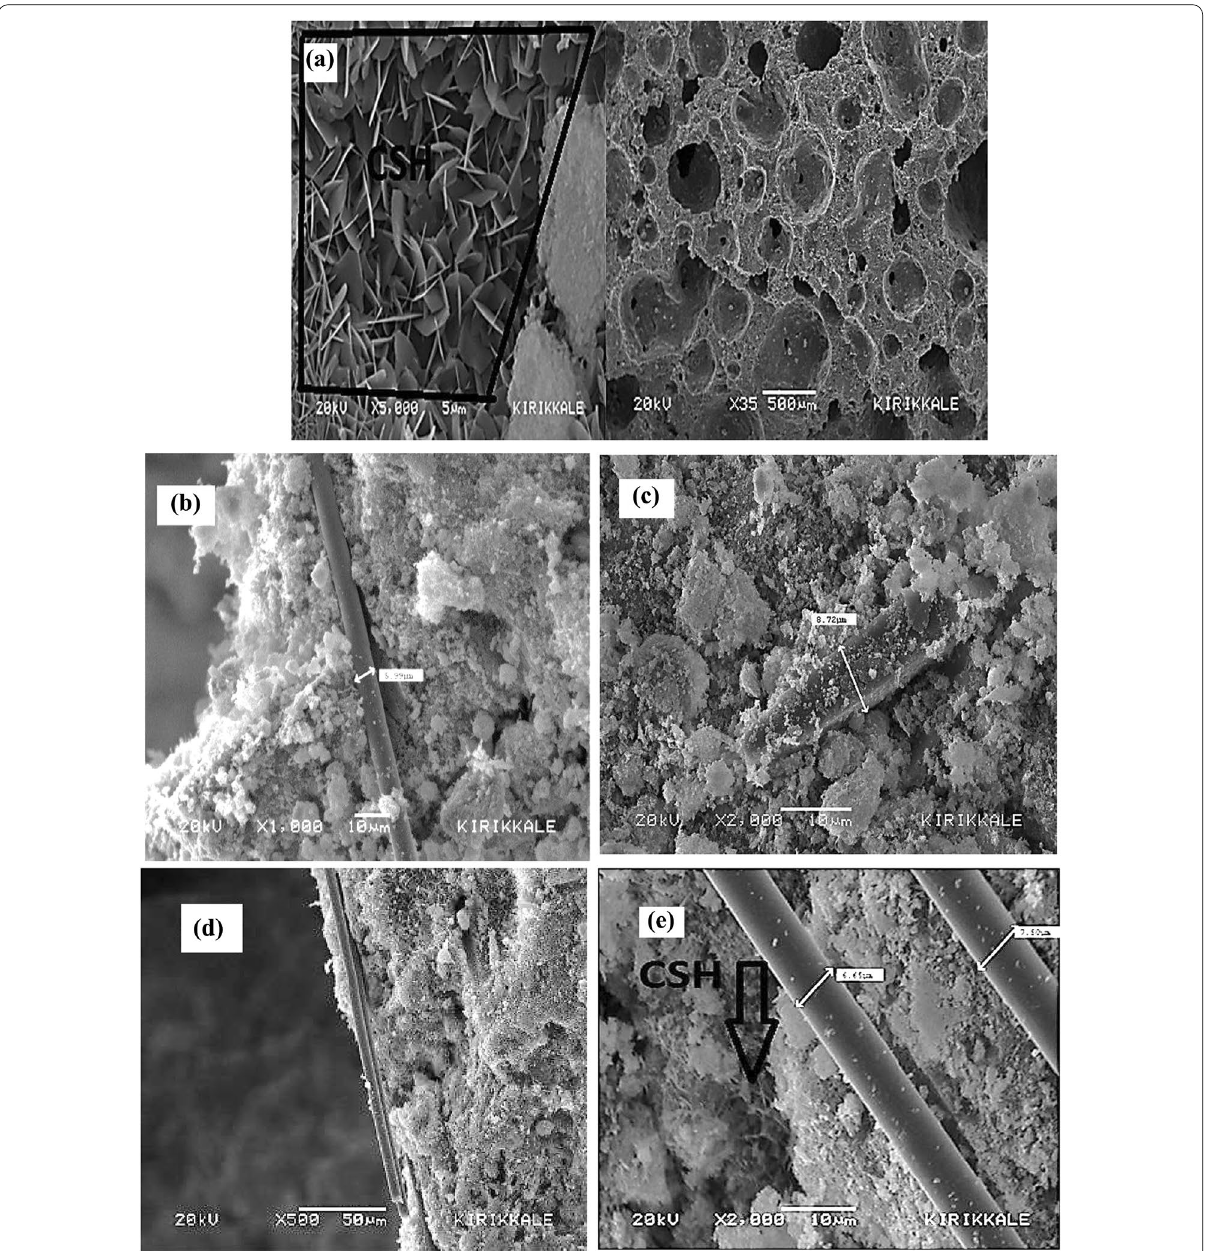
Fig. 4 SEM image analysis of a reference AAC; b basalt FRAC ( fiber FRAC ( 500) (Pehlivanlı et al., ×